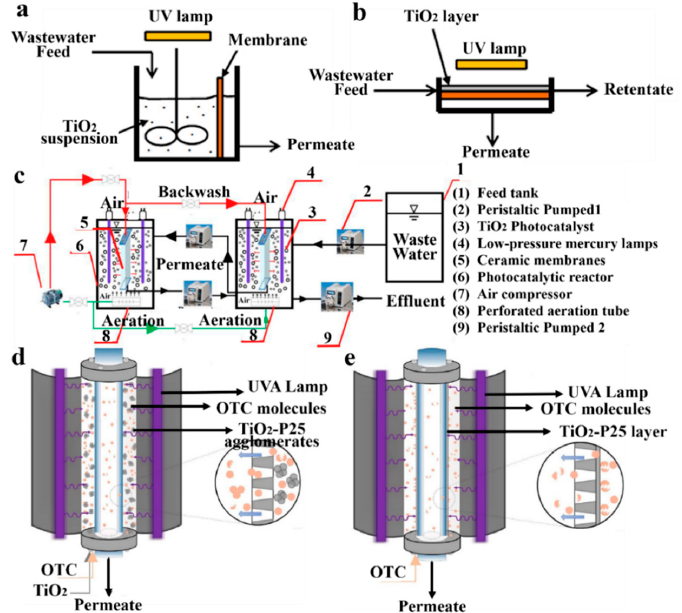
Figure 9. Configurations of photocatalytic membrane reactors: submerged membrane in a slurry reactor ( a ) and TiO 2 coated reactor ( b ) [118]. Copyright 2014, Elsevier. Schematic of the submerged ceramic membrane photocatalytic reactor (SCMPR) ( c ) [120]. Copyright 2019, Elsevier. Schematic rep- resentation of reactor movable polypropylene flanges and membrane module with TiO 2 in suspension ( d ) and with TiO 2 immobilized on the membrane shell-side ( e ) [28]. Copyright 2019,